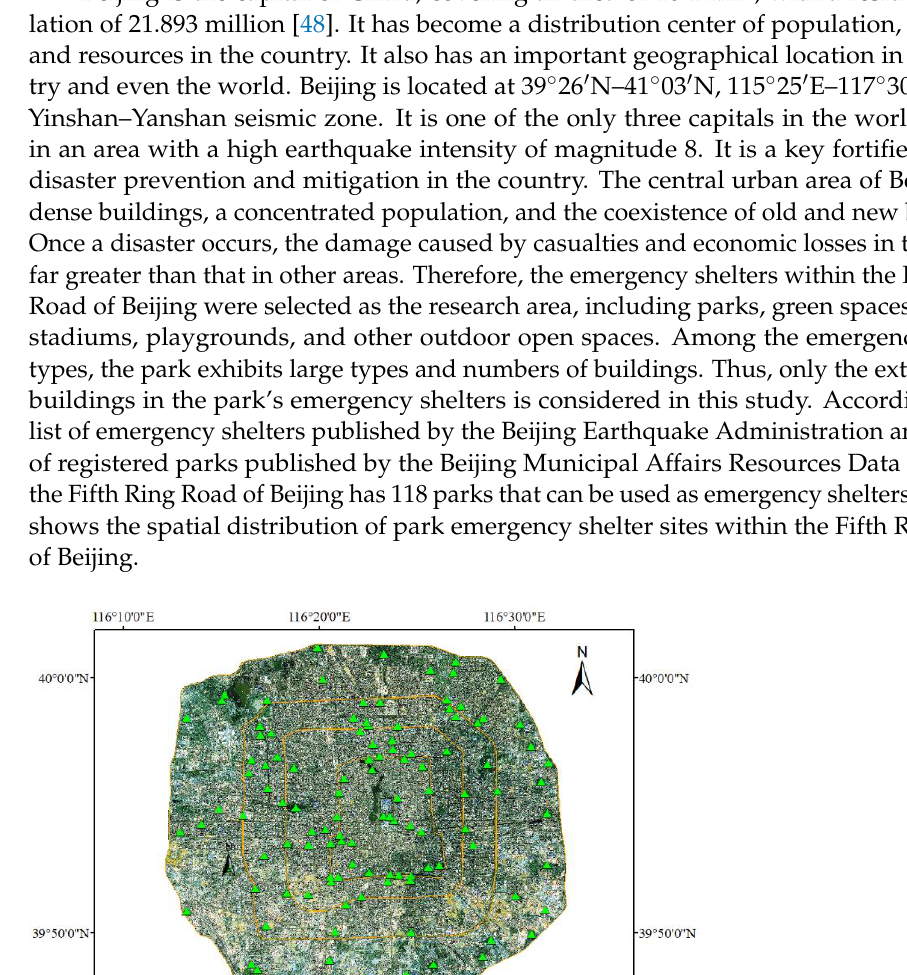
Figure 6. Part of the details of WHU aerial building dataset and Google building dataset of emer- gency shelters within the Fifth Ring Road of Beijing. ( a ) WHU aerial building dataset. ( b ) Google building dataset of emergency shelters within the Fifth Ring Road of Beijing. WHU aerial building dataset: The WHU dataset is divided into an aerial building dataset and a satellite building dataset. Given that the data used in this study are Google Images, the WHU aerial building dataset is similar to Google Image features. Thus, the standard open-source high-resolution WHU aerial dataset was used in this study as the training sample for transfer learning. The dataset was acquired in New Zealand, covering 220,000 buildings of different shapes, colors, and sizes, with an area of 450 km 2 . The initial spatial resolution of the image is 0.075 m. Considering the memory and operating effi- ciency of the computer, Ji et al. [49] downsampled the spatial resolution of the image to 0.3 m and cropped the image in the area to a size of 512 × 512 pixels, forming an image dataset with 8188 images, including 4736 in the training set, 1036 in the validation set, and 2416 in the test set. Google building dataset of emergency shelters within the Fifth Ring Road of Beijing: The dataset uses Google’s high-resolution remote sensing imagery with a spatial resolu- tion of 0.23 m. We selected 21 typical parks with varying image sizes using expert visual interpretation to produce ground truth values for model training and evaluation. The 21